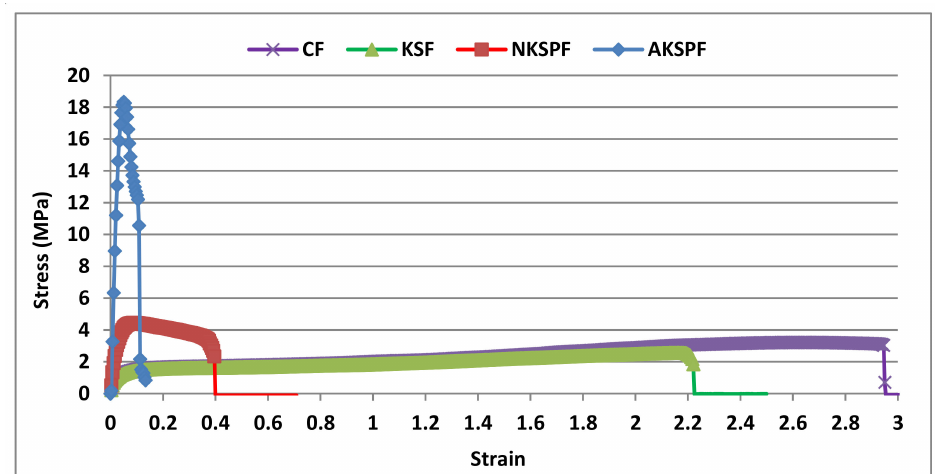
Figure 2. Representative tensile curves for the CF (films without KS), KSF (films with KS that was not retained in particles), NKSPF (films with KS retained in NKSP) and AKSPF (films with KS retained in AKSP).